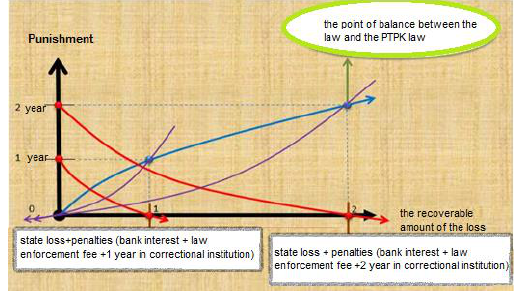
Fig.1 : Corruption Crime and Recovery of Loss Value; Source: the results of research analysis by the authors